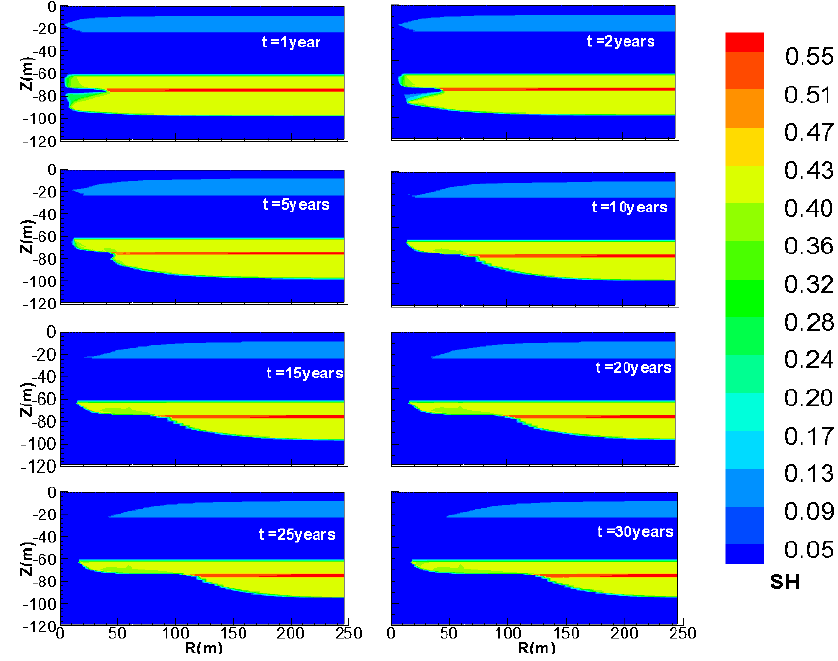
Figure 11. Reference case: evolution of the hydrate saturation ( S H ) distribution overtime.